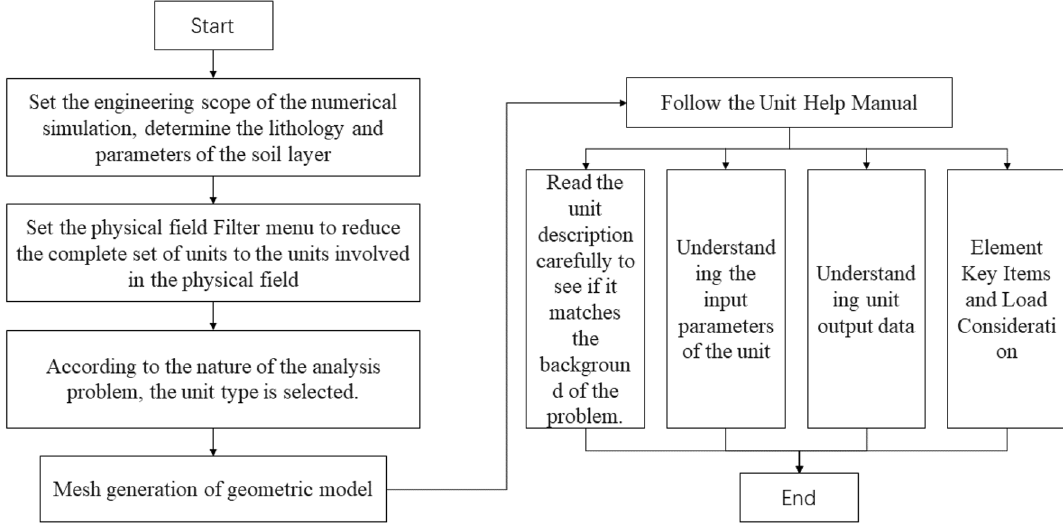
Figure 5. Modeling stages process of Lijiazhai slope numerical model.